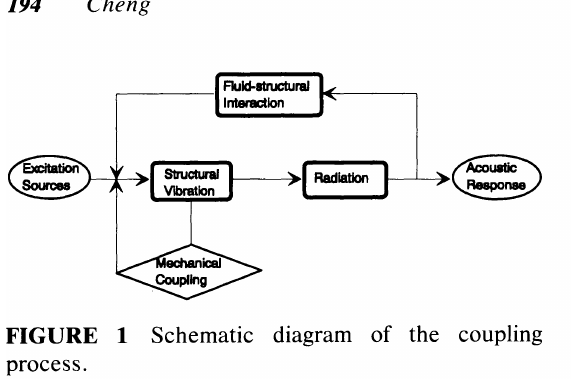
FIGURE 1 Schematic diagram of the coupling process.